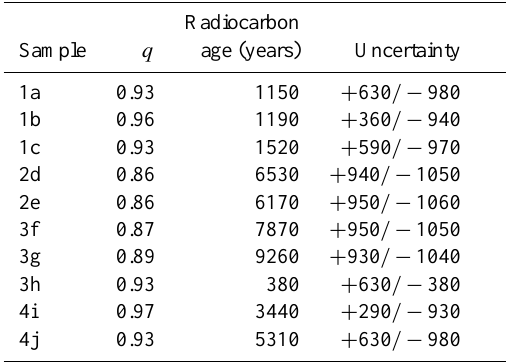
Table 2. Radiocarbon ages of groundwater in the Gellibrand Catch- ment corrected for calcite dissolution. Uncertainties are calculated varying q by ± 0.1 plus the analytical uncertainty of a 14 C from Ta- ble